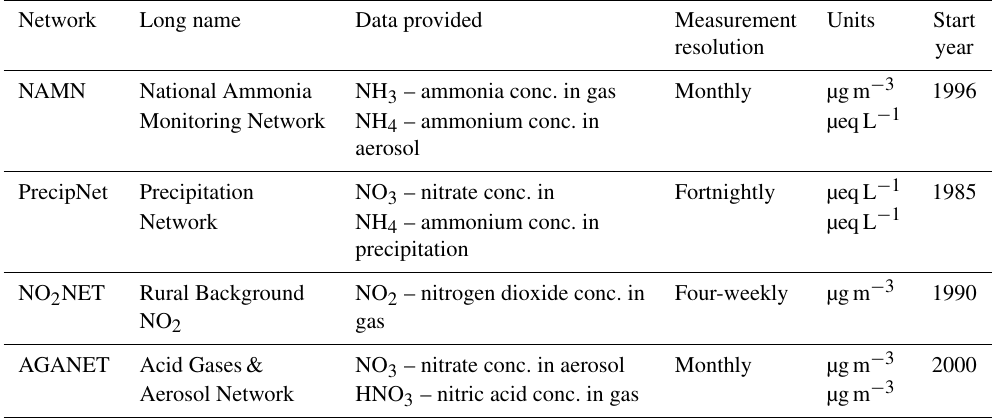
Table 3. Four measurement networks used within the UK Acidifying and Eutrophying Atmospheric Pollutants (UKEAP) network, along with the 10 compounds used to evaluate the atmospheric